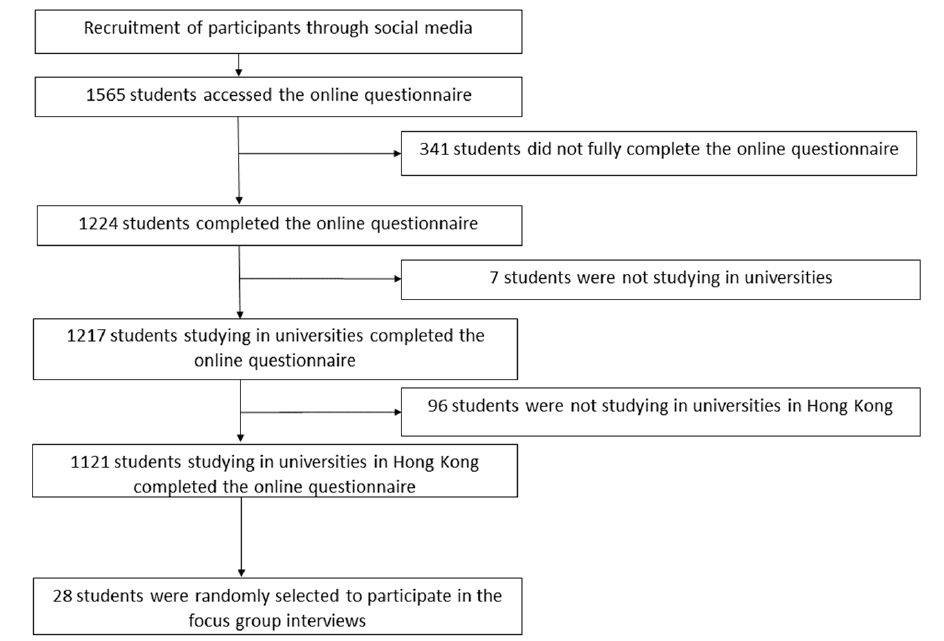
Figure 1. Recruitment flow chart. Table 1. Students’ characteristics ( n = 1121).